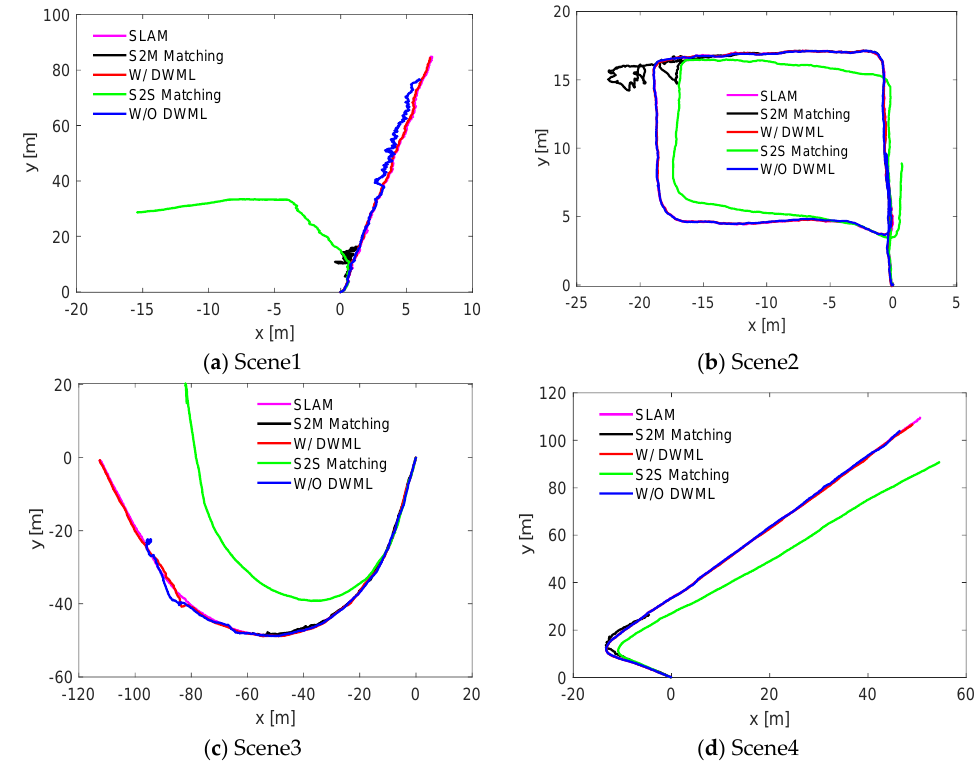
Figure 16. Comparative analysis of the localization methods for four underground roadway scenes.